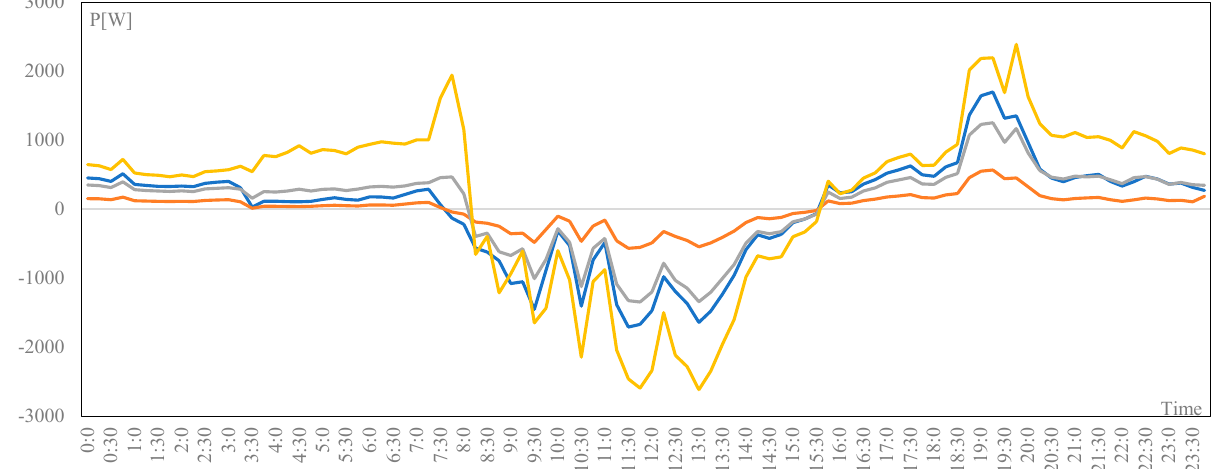
Figure 22. Exchanged power with the storage system for the different AEUs: AEU1 (blue), AEU2